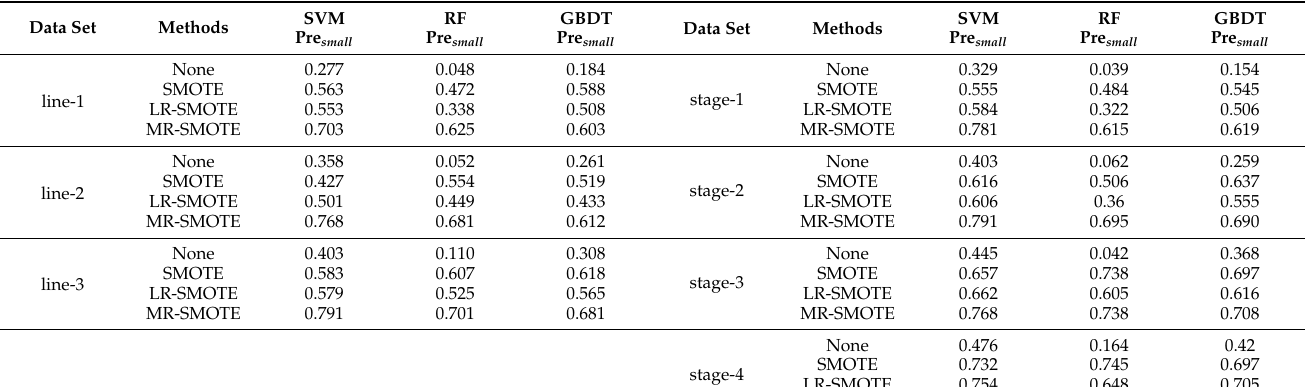
Table 8. Pre small on the data sets.